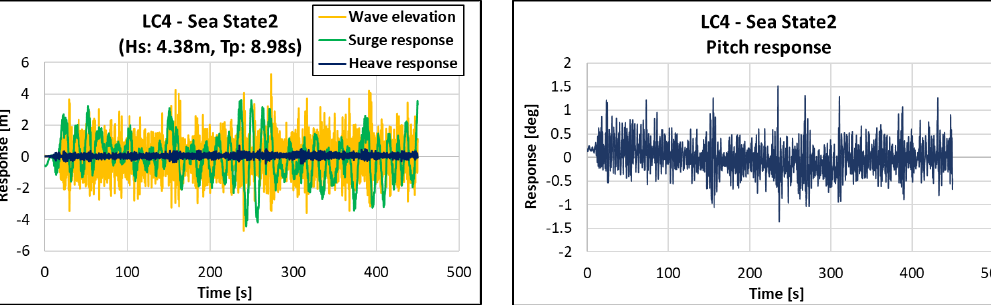
Figure 14. Sea state2: LC3 and LC4 result under irregular waves.